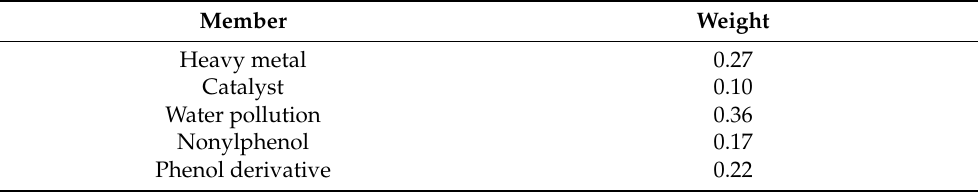
Figure 13. Thematic network for the third period (2011–2015). Table 7. The weight of lines connected to the main theme “water